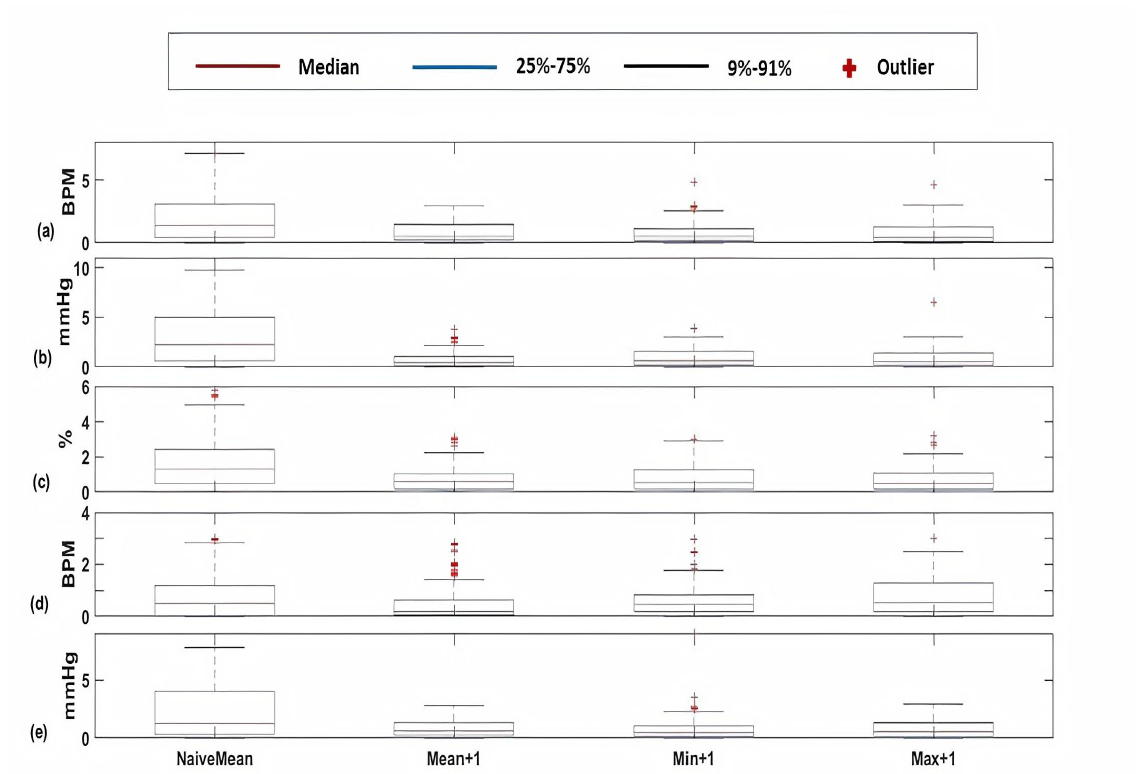
Figure 11. Box-plots of the absolute errors of the Naive predictor of the mean value and the proposed algorithm of kNN-LS-SVM of the mean, minimum, and maximum values at the upcoming hour for the vital signs ( a ) HR (BPM), ( b ) SBP (mmHg), ( c ) Sp O 2 (%), ( d ) RR (BPM), and ( e ) PP (mmHg) for Dialysis patients.